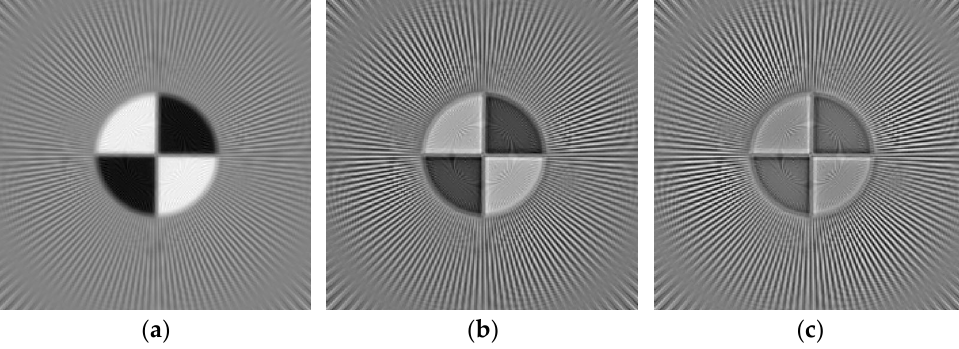
Figure 6. Local centers of digital resolution chart images reconstructed by basic filters with different parameters: ( a ) λ = 1/2; ( b ) λ = 3/4; ( c ) λ =